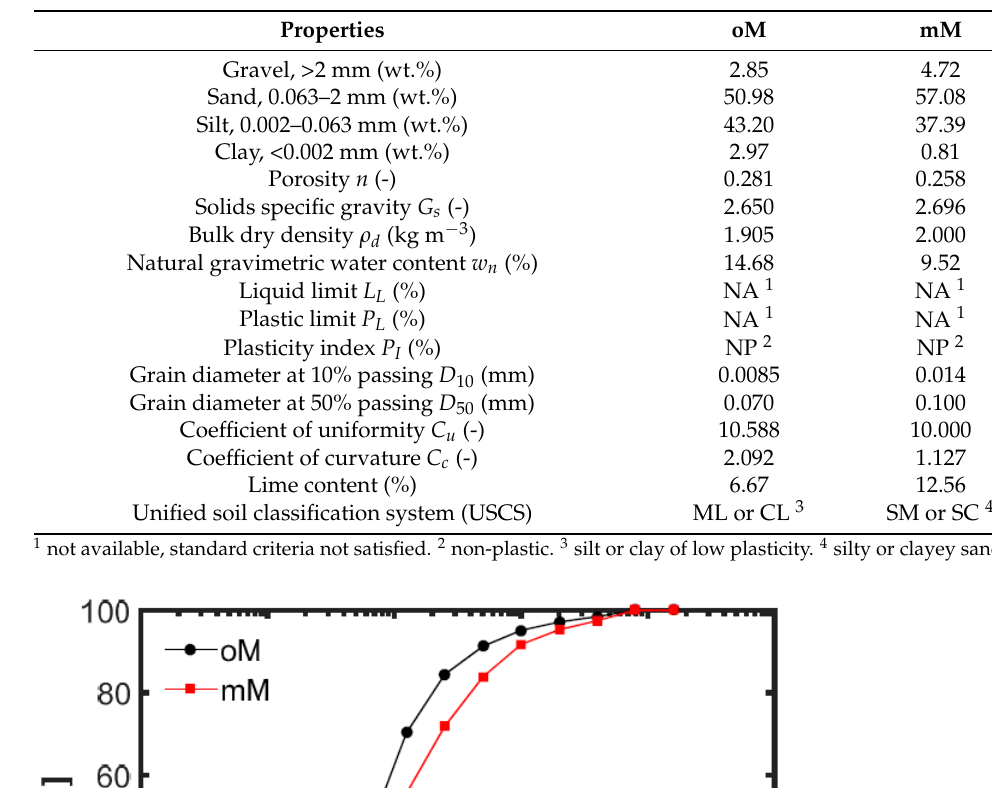
Table 1. Geotechnical properties of the glacial till soils obtained through measurements at Kiel University.